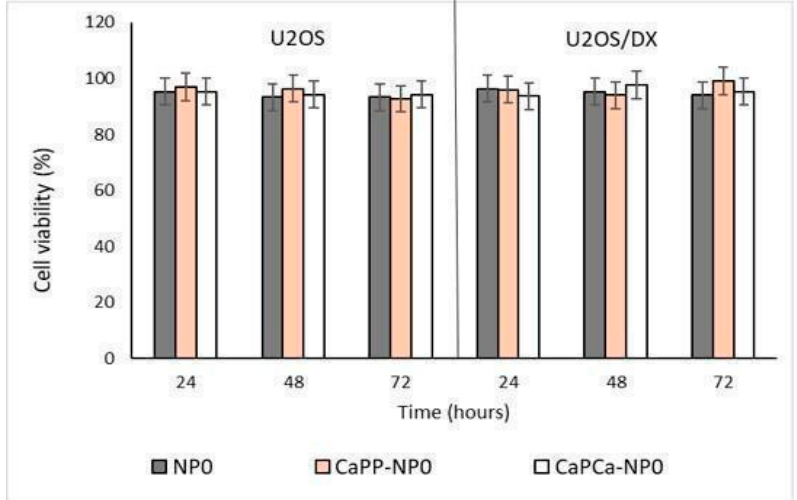
® 80 aqueous solution, NP6, and CaP Ca -NP6.